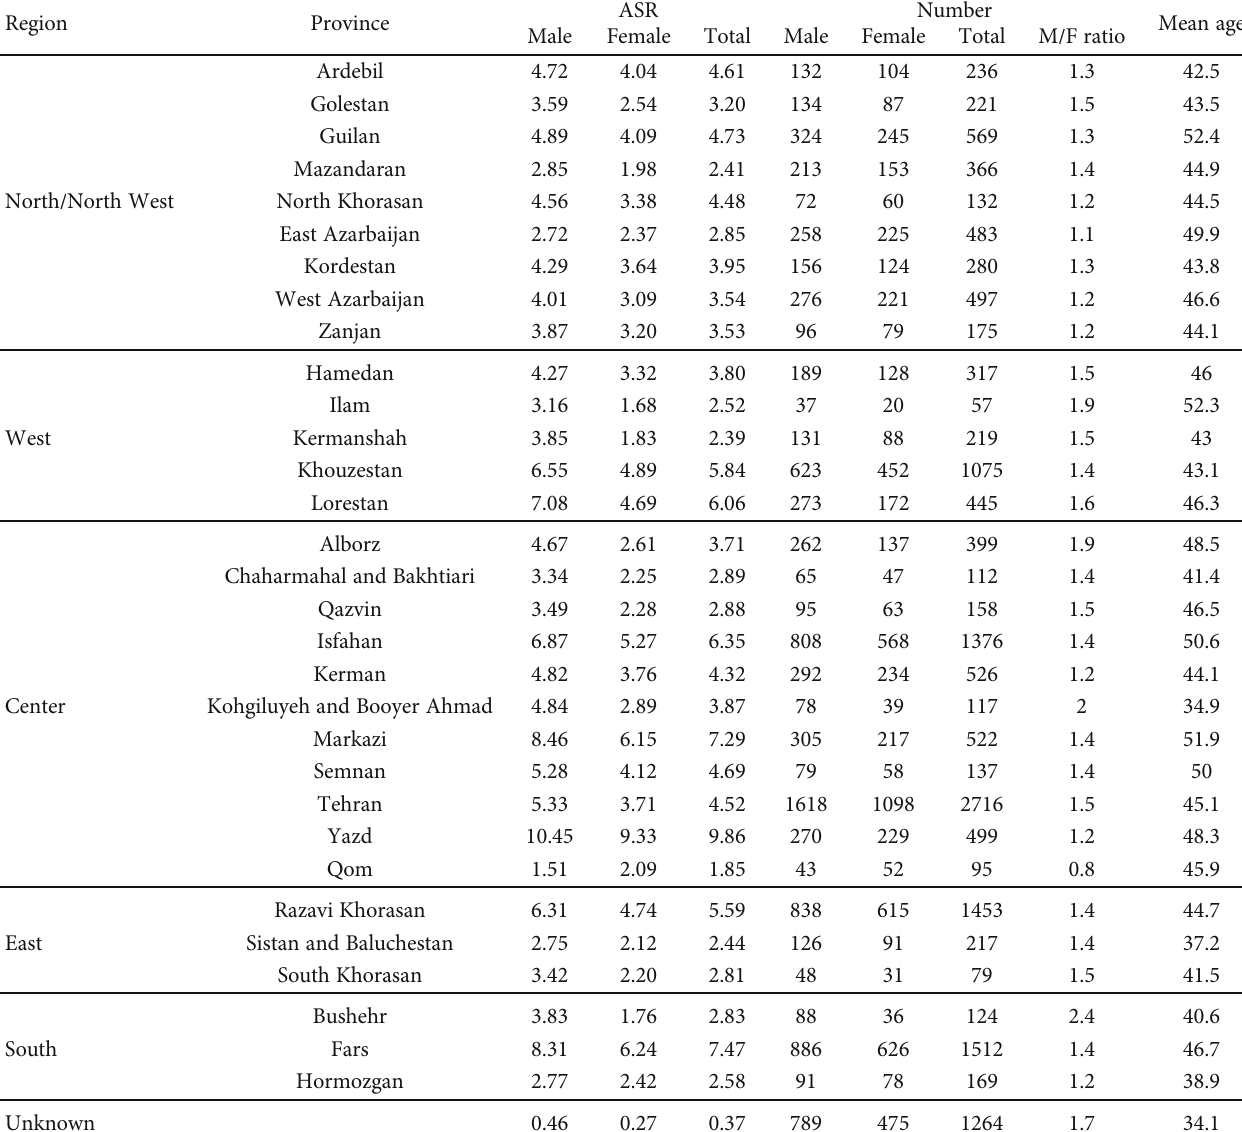
Table 6: Geographical distribution of CNS tumours by